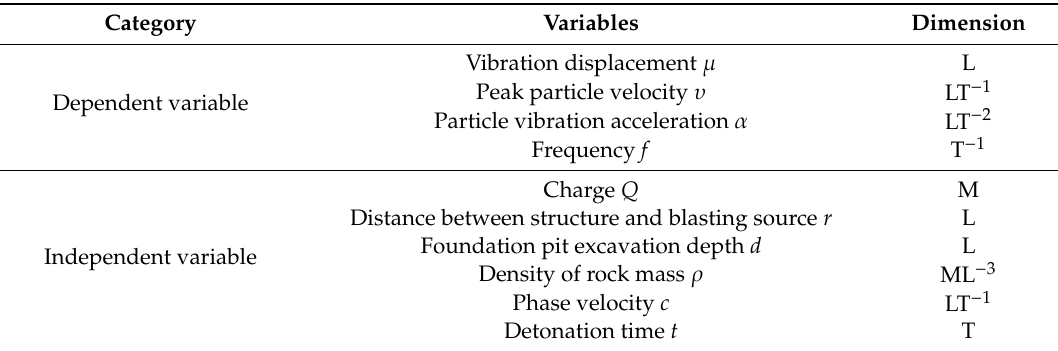
Table 3. Variables related to ground vibration subjected to foundation pit